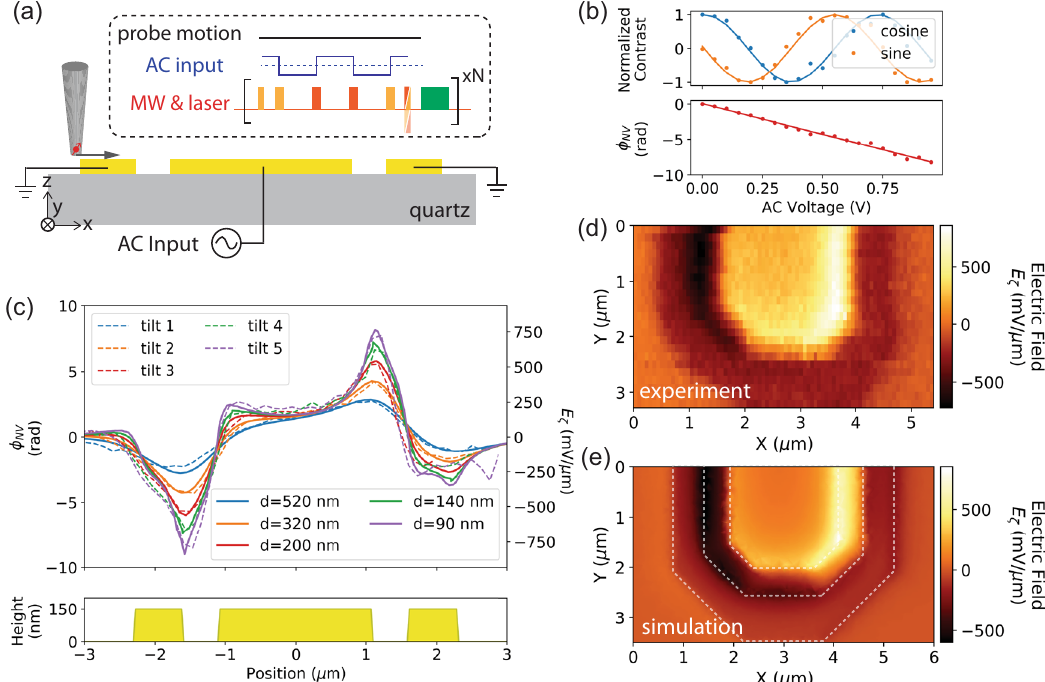
Fig. 3 AC electric fi eld imaging. a Schematic of scanning NV microscopy and the pulse sequence for AC electrometry. The probe oscillates with an amplitude <1 nm, hence represented by a black fl at curve. The AC reference input is in-phase with the XY-4 detection sequence. b NV measurements performed at a fi xed point within the gap. Top panel: the cosine and sine values measured by rotating the phase of the fi nal π / 2 pulse. Bottom panel: Extracted phase ϕ NV proportional to the AC input amplitude. c Top panel: 1D line scans of the NV phase signal ϕ NV at different NV-sample distances controlled by the tilting angle of the diamond probe. The AC input has a peak-to-peak amplitude of 0.96 V. Dashed traces are the experimental data, and solid traces show the COMSOL simulation. Bottom panel: the height pro fi le of the metal. d 2D mapping of the AC electric fi eld distribution in the U-shaped Au structure. e Simulated electric fi eld distribution along the maximum coupling ^ ζ ^ ζ axis at a distance of 90 nm. The azimuth angle of with respect to the coordinate system shown in ( a ) is ϕ = 20°, and the zenith angle θ = 45°. The white dashed lines outline the edge of the Au structure used in the